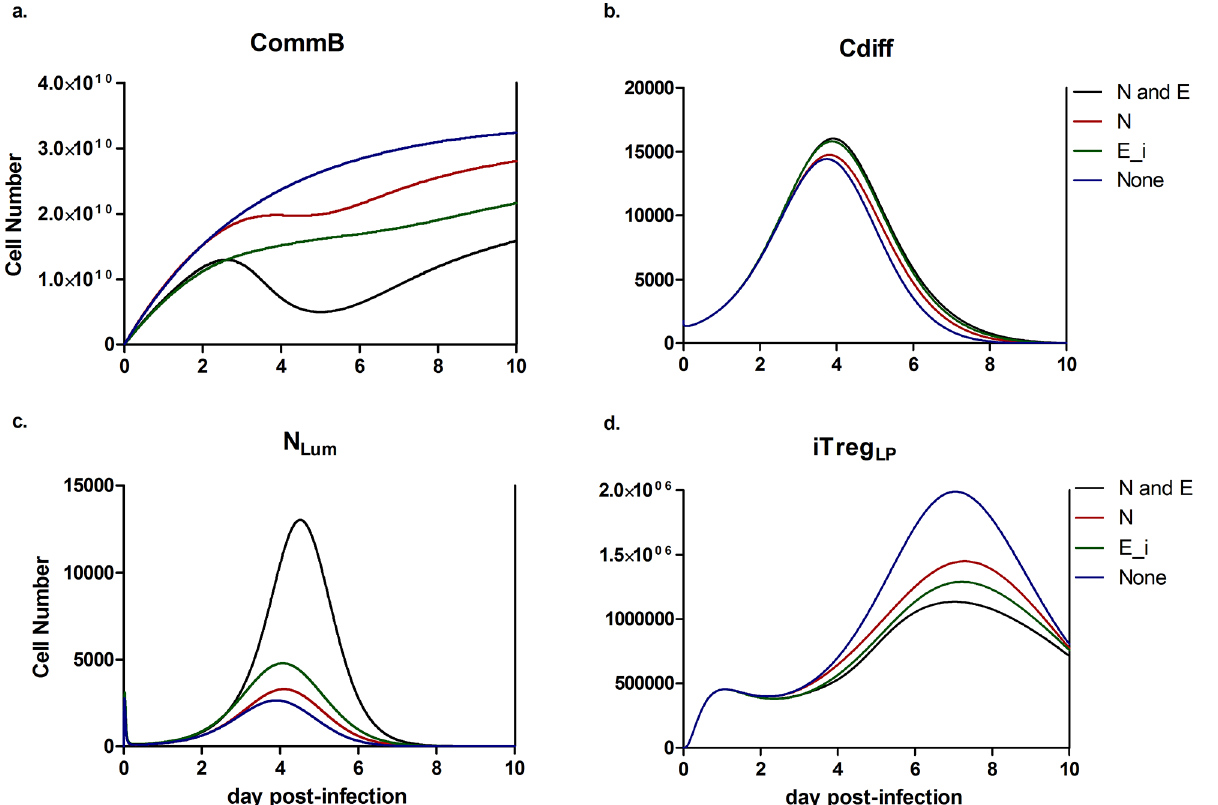
Fig 6. In silico simulation of altered commensal bacteria regrowth during Clostridium difficile infection. Four cases were tested with variations to the inhibition of the commensal bacteria growth: inhibited by both neutrophils and inflamed epithelial cells (N and E_i), by only neutrophils (N), by only inflamed epithelial cells (E_i), and by neither (none). Resulting changes in species populations for each case are shown: (a) baiCD -containing commensal species, (b) C . difficile , (c) activated neutrophils, and (d) iTreg cells in the lamina propria.